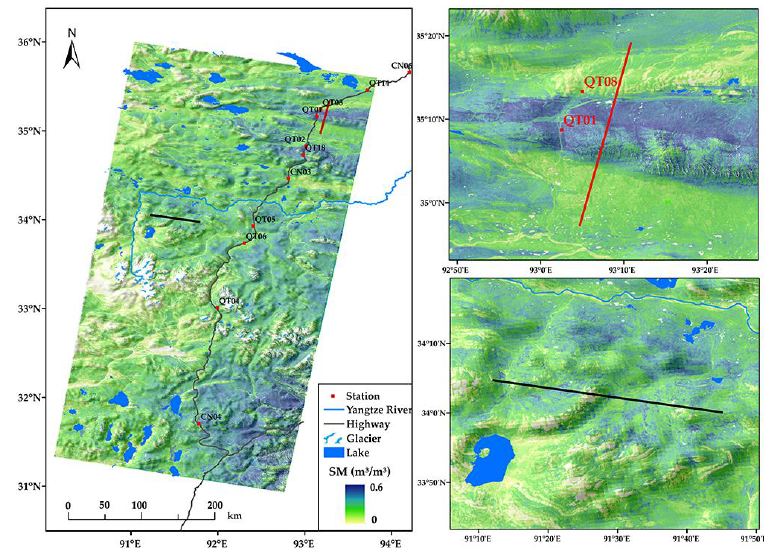
Figure 9. The spatial distribution of the SM and the location of the two transect lines.